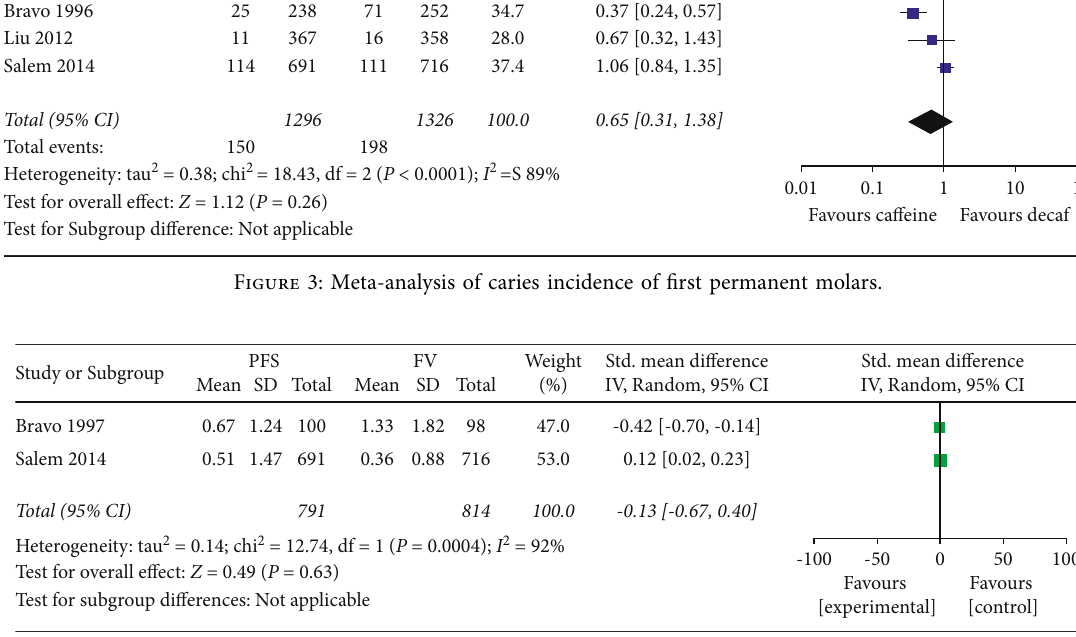
Figure 4: Meta-analysis of caries incidence DMFS (occlusal